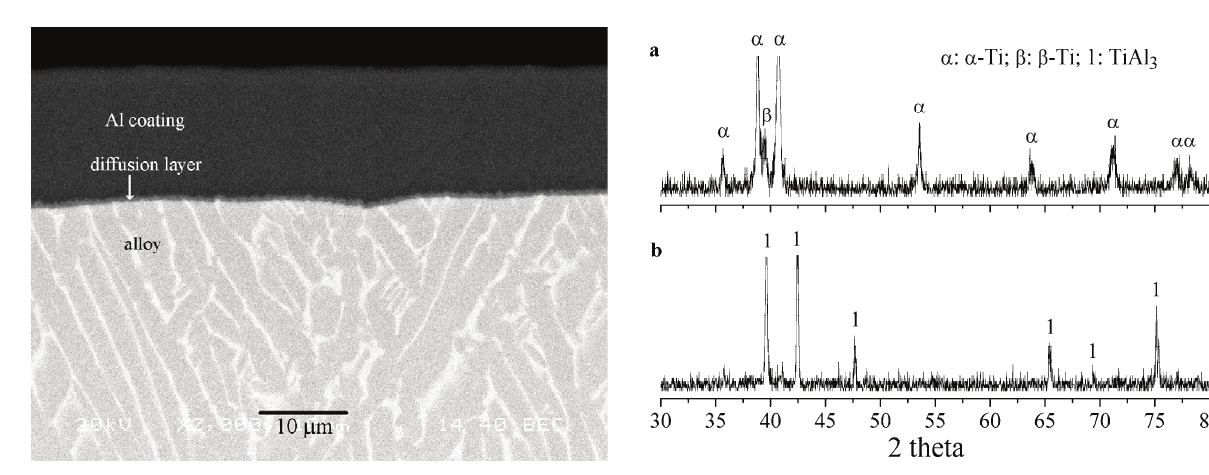
Figure 3. Surface X-ray diffraction patterns before oxida- tion. a – the TA15 alloy; b – the